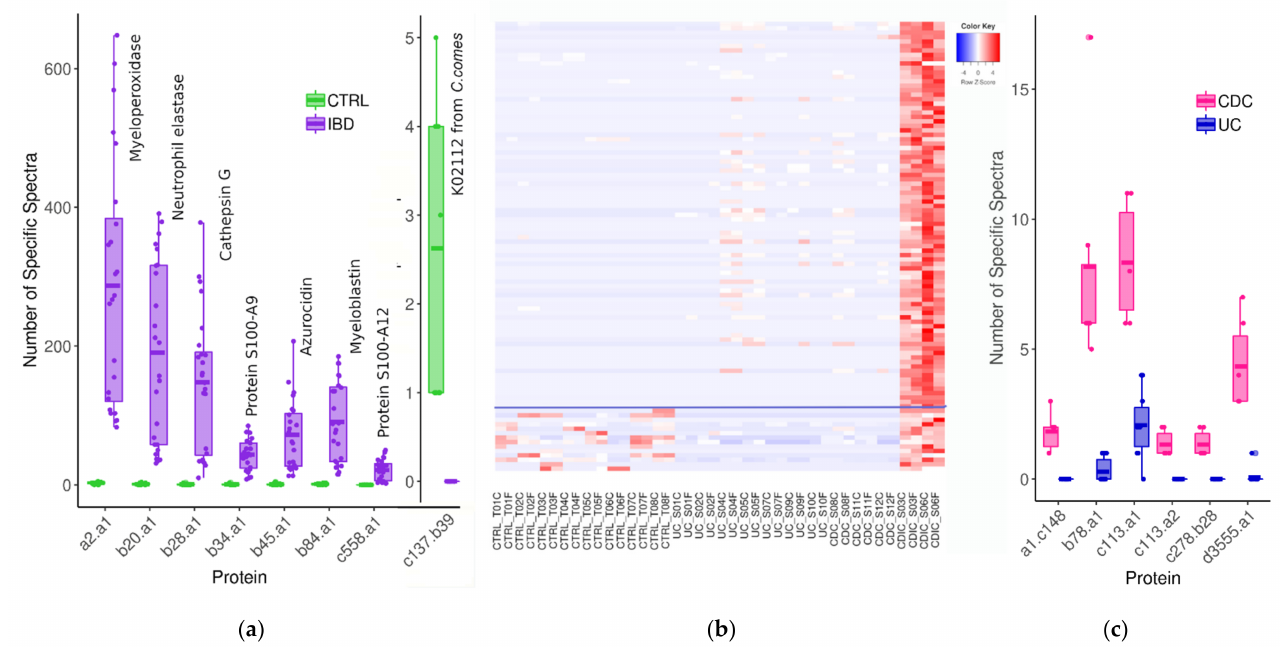
Figure 4. ( a ) Protein subgroups over- and underrepresented in all IBD samples compared to all controls. ( b ) Heatmap of 101 subgroups overabundant in CDIC samples compared to all other IBD samples (see Table S5 for their complete list); 87 of them (over the blue line) were also overabundant compared to controls (data are log-transformed and zero-centred). ( c ) Protein subgroups overabun- dant in all CDC compared to all UC samples. Abbreviations and headcounts of patient groups are those detailed in legend of Figure